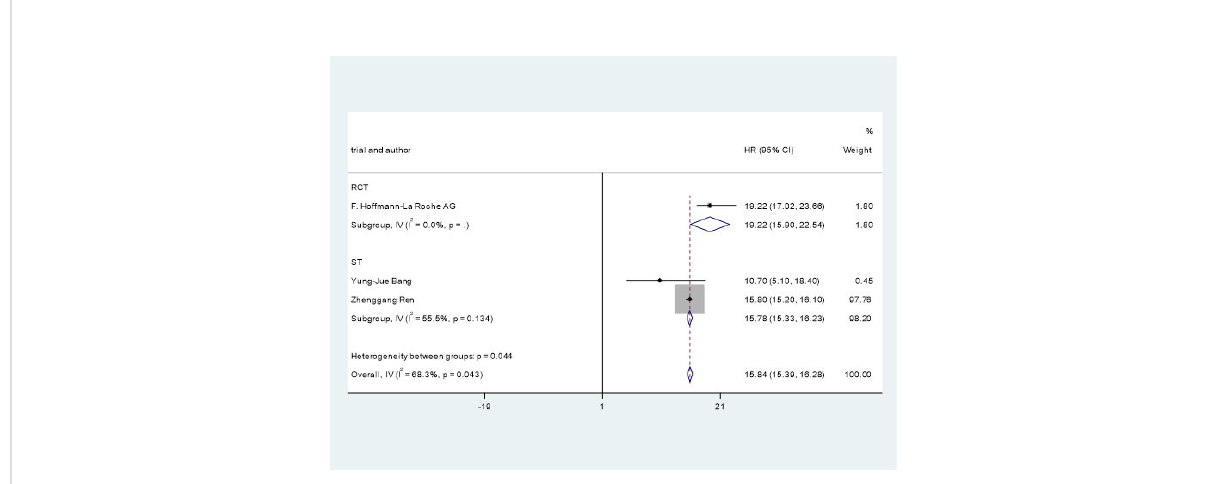
FIGURE 4 Pooled analysis of OS in patients with HCC treated with immune checkpoint inhibitors combined with antiangiogenic